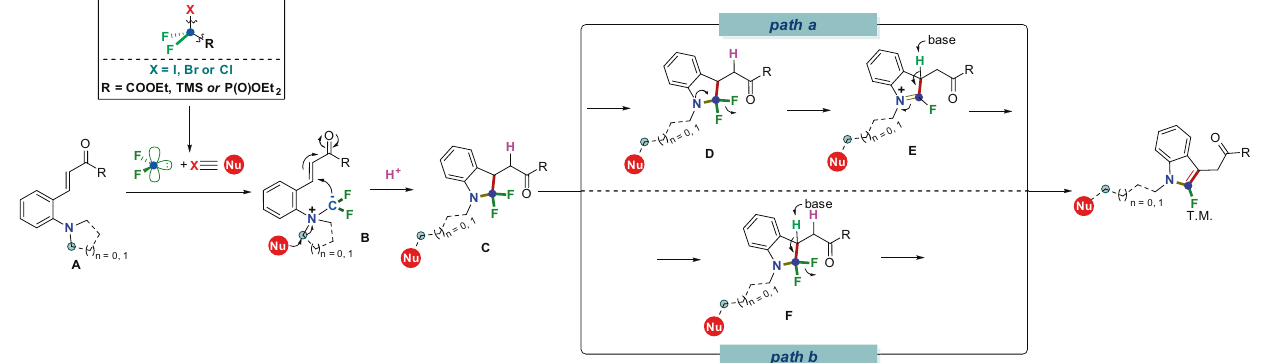
Fig. 8 Plausible mechanism. Possible reaction mechanism of di fl uorocarbene enables to access 2- fl uoroindoles from